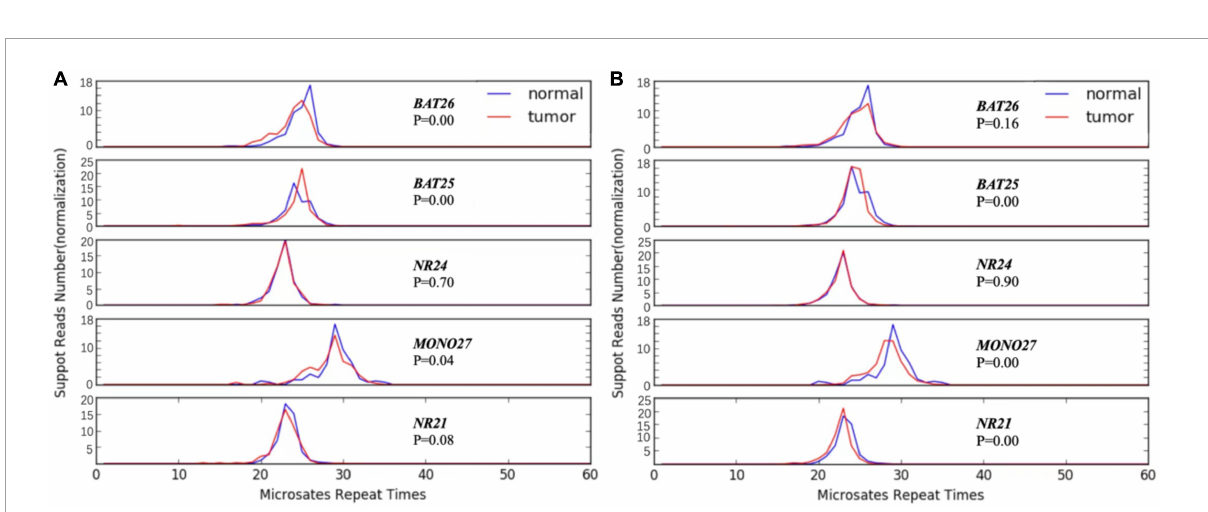
FIGURE2 Polymerase chain reaction analysis of microsatellite markers. (A) The blue curve represents normal tissue, while the red curve represents tumor tissue. In case 1, there was microsatellite instability in BAT26, BAT25, and MONO27 sites between two control tissues ( p < 0.05), which indicated high microsatellite instability (MSI-H). (B) In case 2, there was microsatellite instability in BAT25, MONO27, and NR21 sites between two control tissues ( p < 0.05), which indicated high microsatellite instability